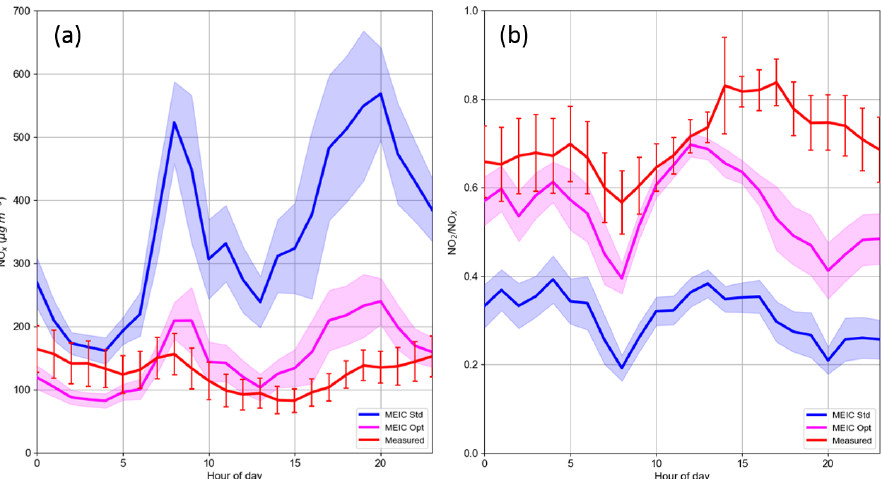
Figure 11. Campaign period mean diurnal variation in modelled and measured (a) NO x concentrations and (b) NO 2 / NO x concentration ratios at the IAP field site. Modelled concentrations produced using both MEIC Std (blue) and MEIC Opt (pink). Measurements marked by red line. Shaded areas and error bars represent the 95% confidence intervals for simulated and measured concentrations, respectively.